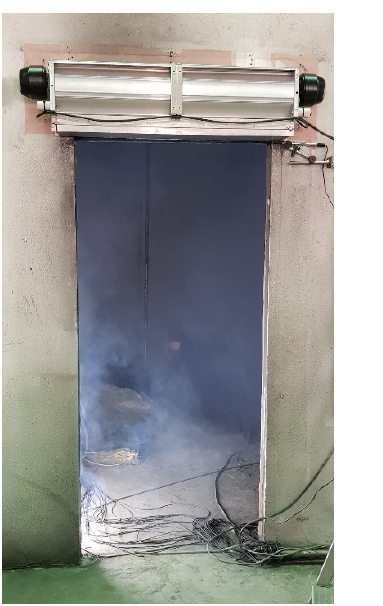
Figure 6. Test results for visual aerodynamic sealing of the air curtain for the nominal nozzle thick- ness of 5 mm.